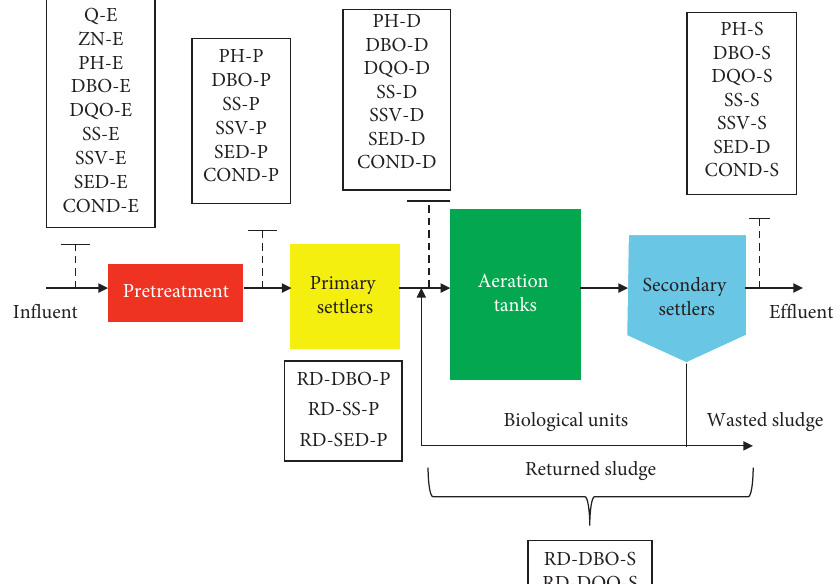
Figure 3: The schematic of the wastewater